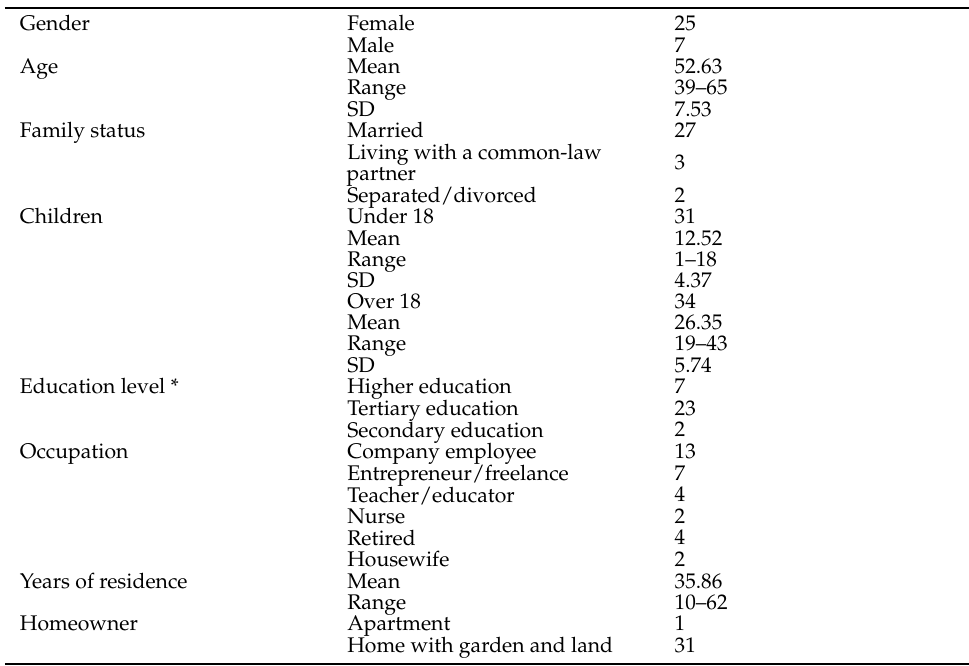
Table 2. Characteristics of the Study Participants ( n =